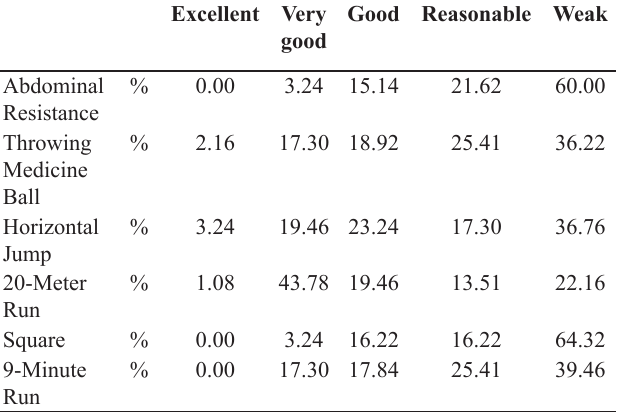
Table 1. Performance of PROESP-BR tests of 185 female students from 15 to 17 years of age from Public Network state schools in Cuiabá-MT, Brazil.